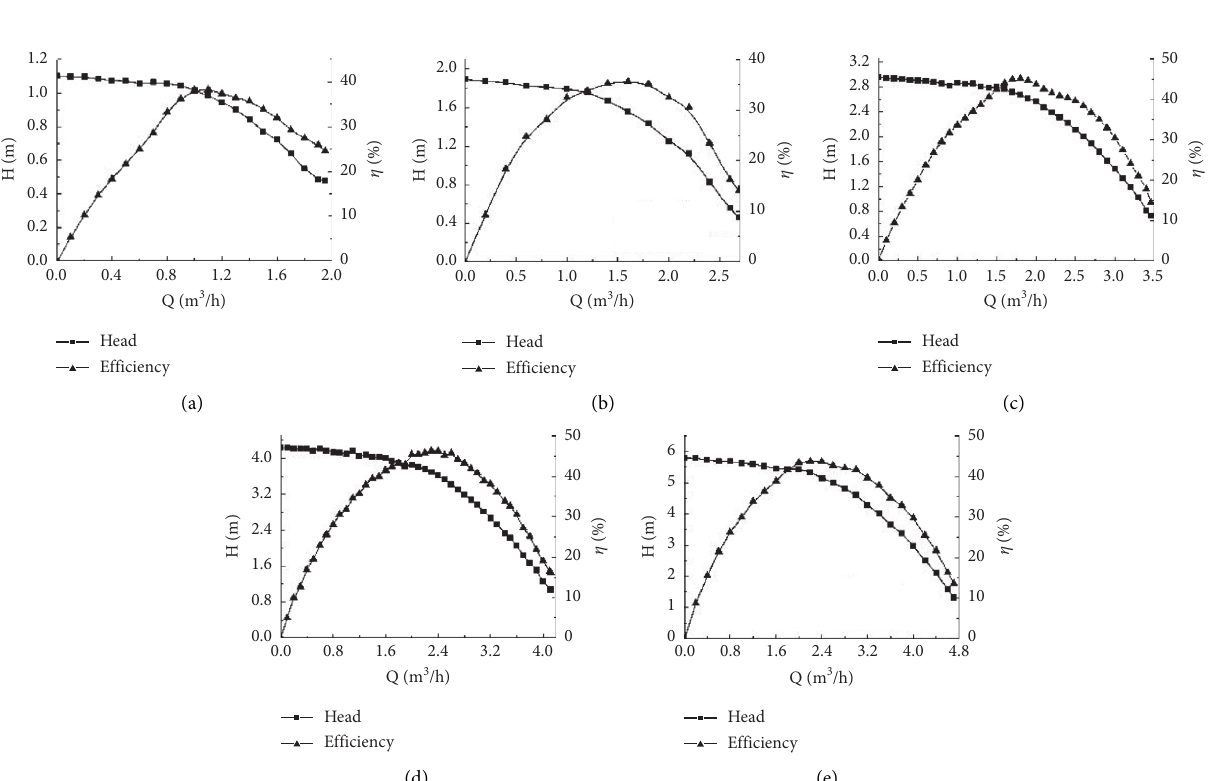
Figure 4: Performance curves of the test pump at five rotation speeds: (a) 600r/min, (b) 800r/min, (c) 1000r/min, (d) 1200r/min, and (e) 1400r/min.